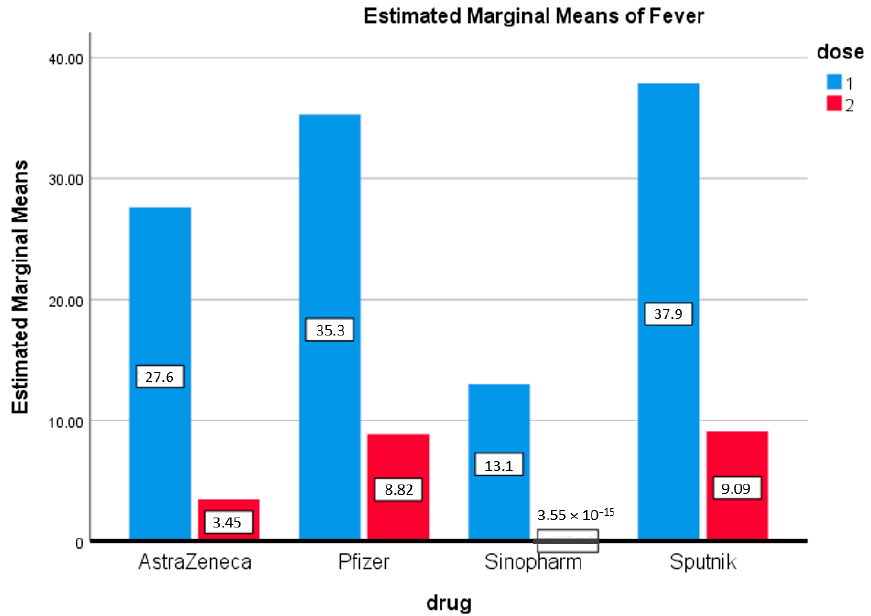
Figure 1. Pain at the Injection Site. Estimated marginal means of pain at the site of injection after the first and second doses of vaccines used in the Kingdom of Bahrain.